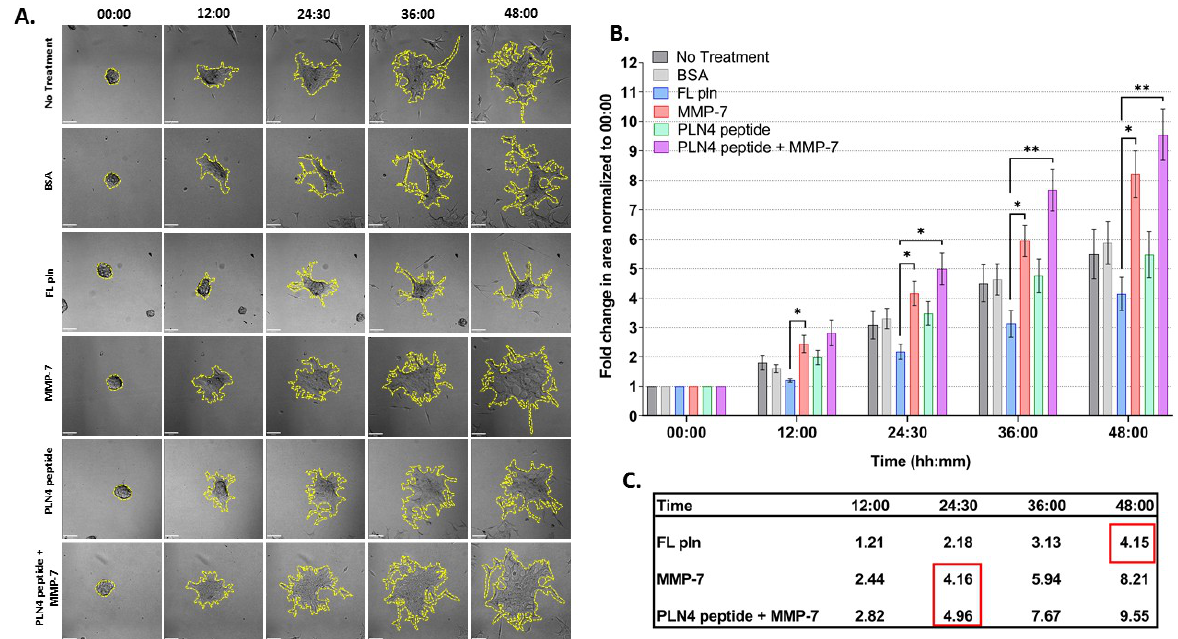
Figure 5. Time course analysis of microtumor dispersion under control conditions (no treatment, BSA) or in the presence of FL pln, MMP-7 and/or PLN4 peptide. ( A ) Representative micrographs showing cell dispersion of C4-2 microtumors with the indicated treatments and time points (scale bar: 100 µm). Yellow dotted lines on the micrographs show the region of interest corresponding to total microtumor dispersion area used to compute area fold change. ( B ) Evaluation of area fold change. Cell dispersion area is higher in microtumors treated with MMP-7 or MMP-7 in combination with PLN4 peptide compared to microtumors treated with FL pln (see text). Data are the mean ±SEM of three experimental repetitions, except two experimental repetitions for PLN 4 + MMP-7. * p < 0.05, ** p < 0.01. Two-way repeated-measures ANOVA with a post hoc Šídák test was performed. ( C ) Table shows mean values for fold change in area. Red wireframes demonstrate that the difference in time needed to reach a similar amount of dispersion in the different treatment conditions.